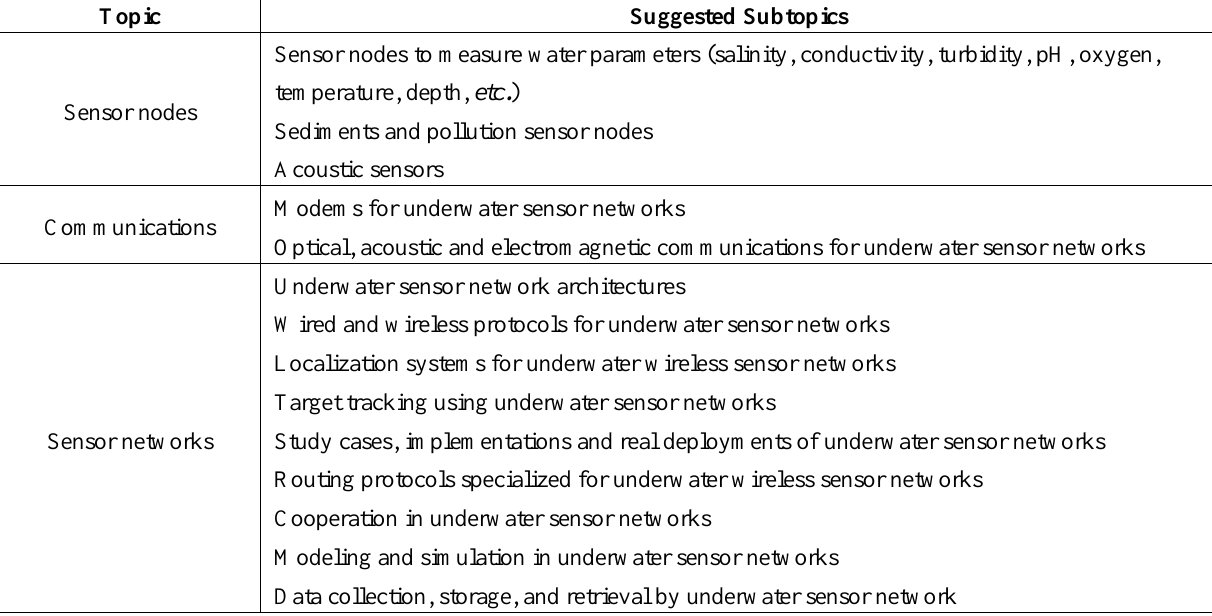
Table 1. Classification of topics included in the Special